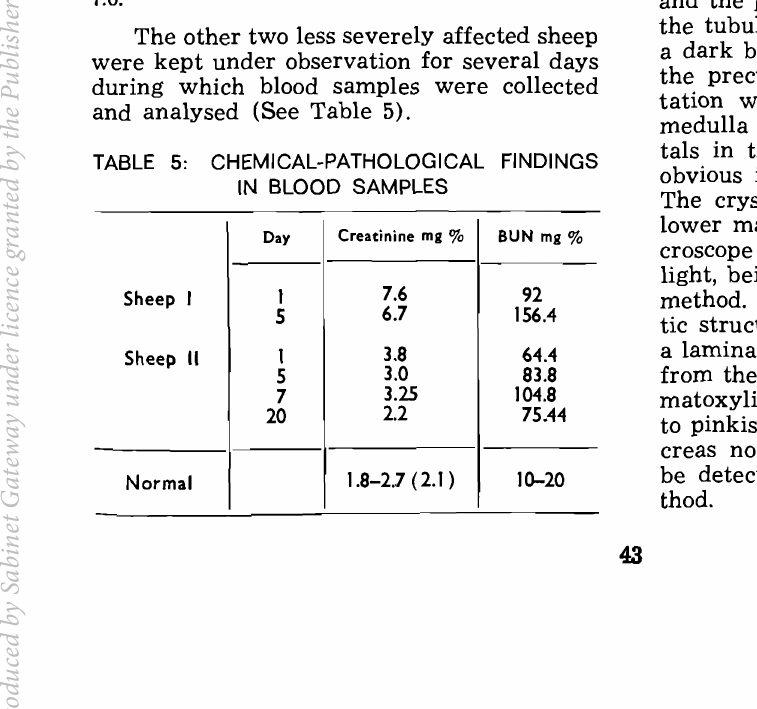
TABLE 5: CHEMICAL-PATHOLOGICAL